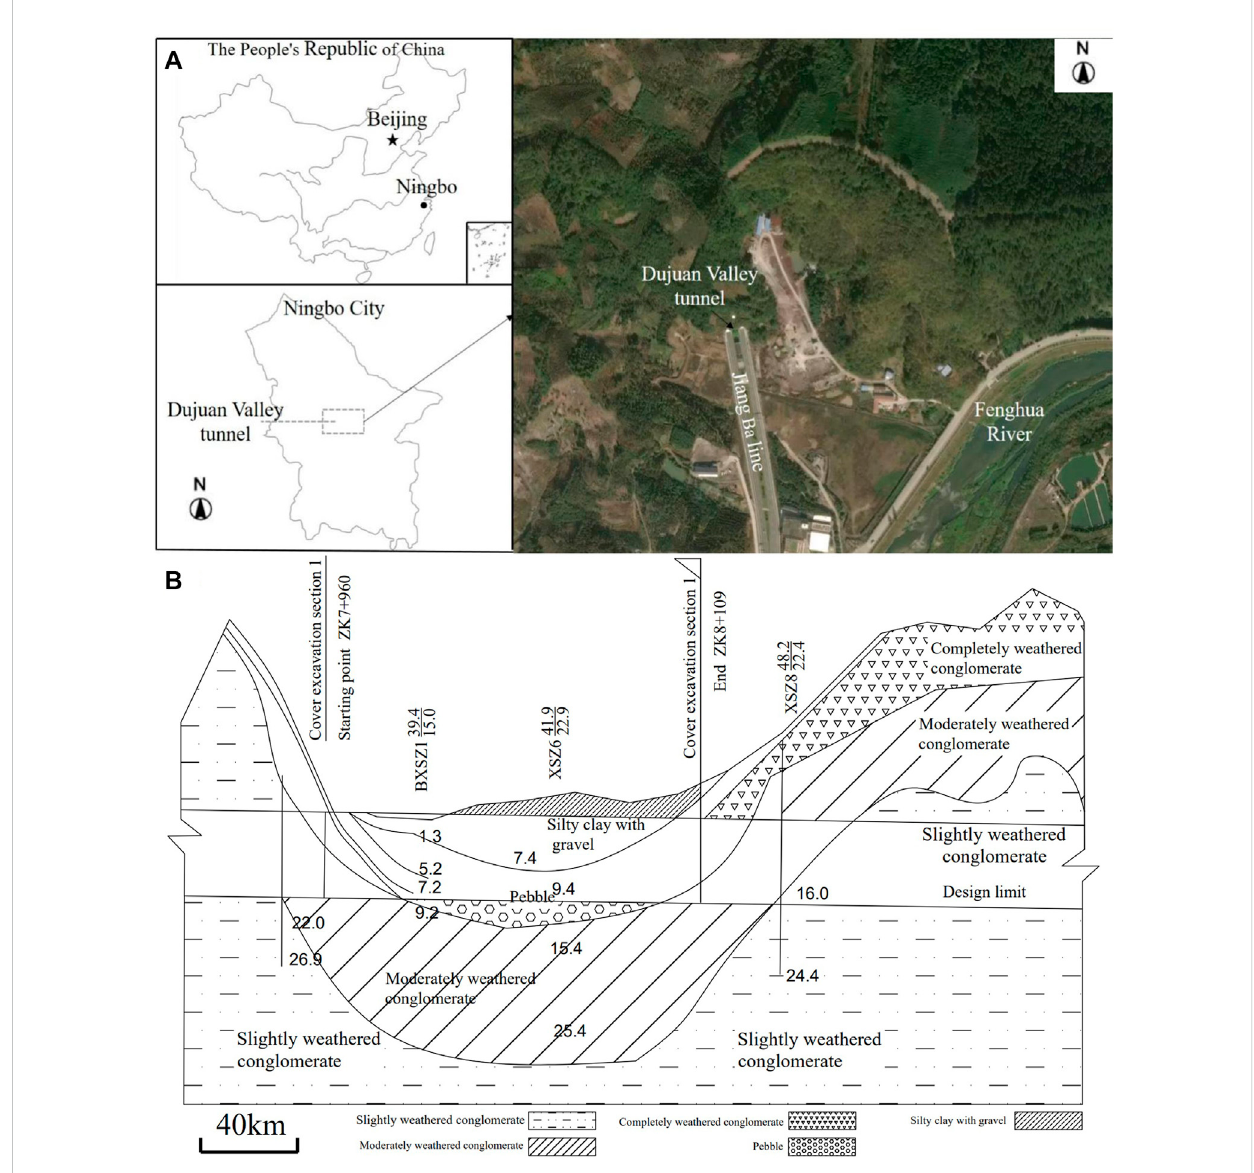
FIGURE 1 Engineering geology map of the tunnel location: (A) Plan of the tunnel; (B) A cross-section view of the tunnel.